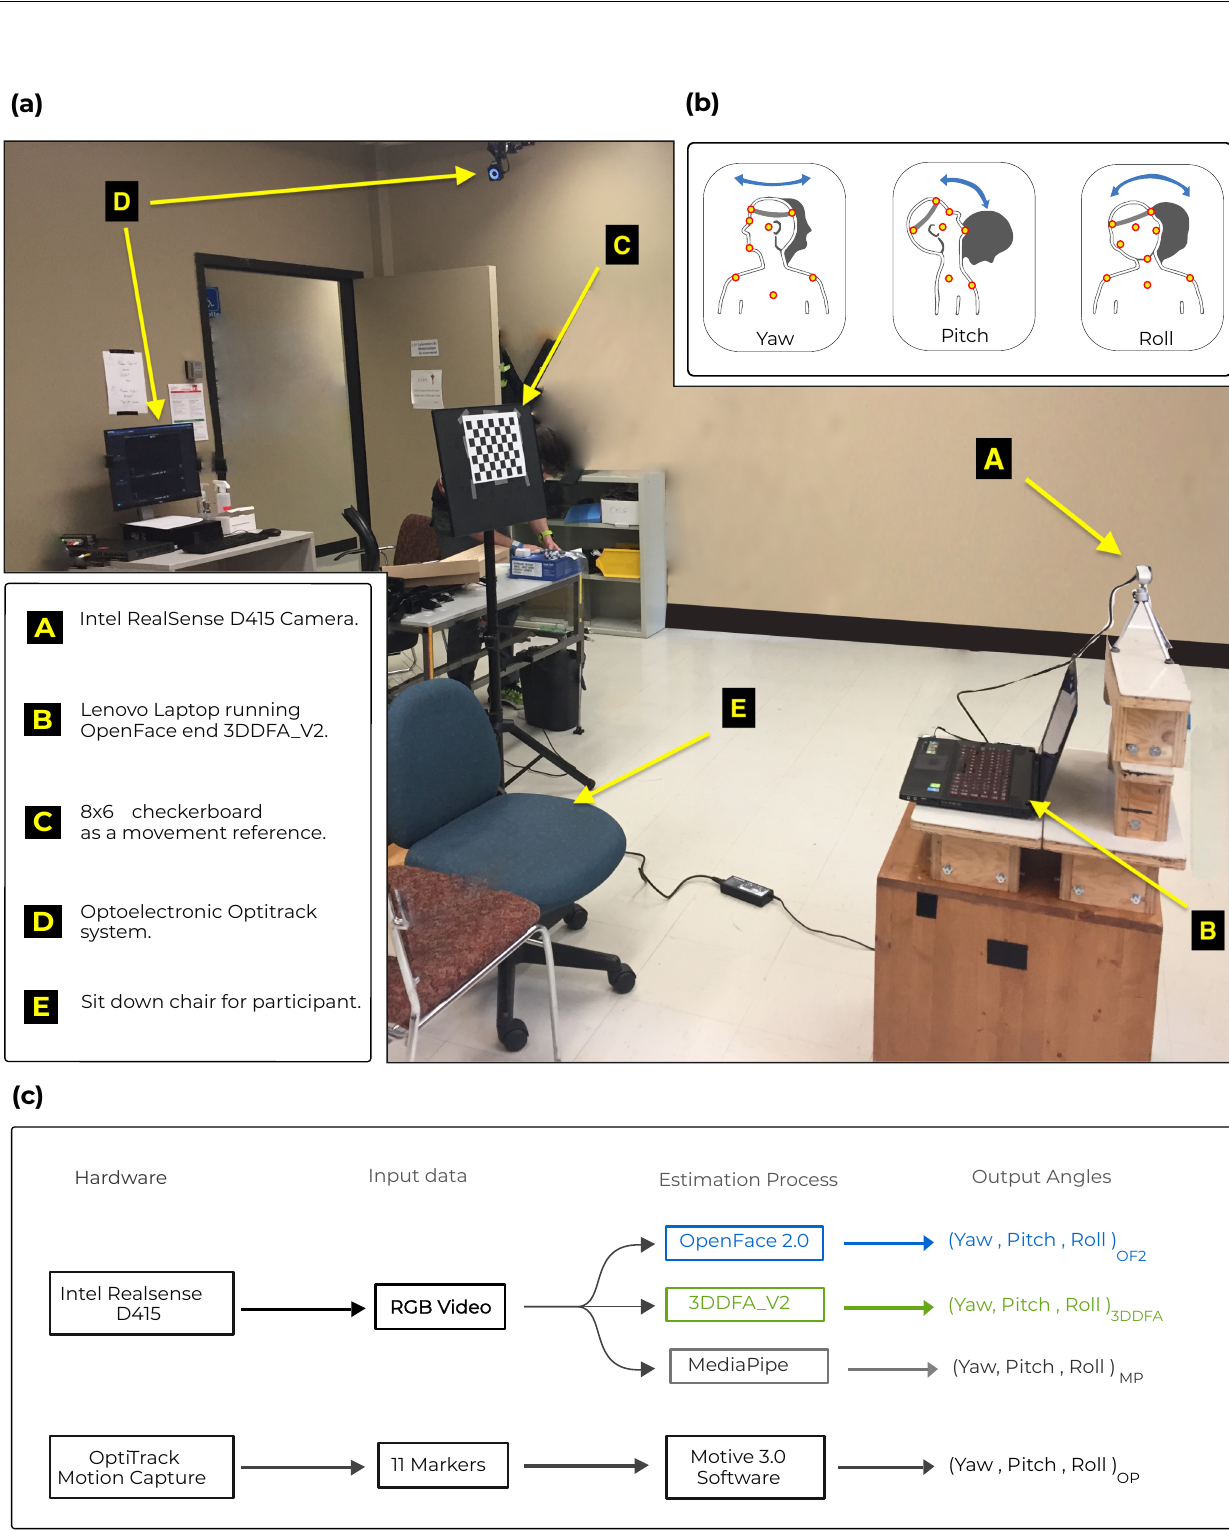
Figure 1. Methodology overview. Panel ( a ) General laboratory setup including the RGB camera in A, the laptop in B, the 8 × 6 checkerboard used to ancre movement into the environment in C and the optoelectronic motion-capture system in D. Panel ( b ) Head orientation movements acquired including head rotation (yaw), flexion-extension (pitch) and lateral flexion (roll). The orange circles illustrate the position of retro-reflective markers. Panel ( c ) Data flow process for both gold standard and camera-based pose estimation